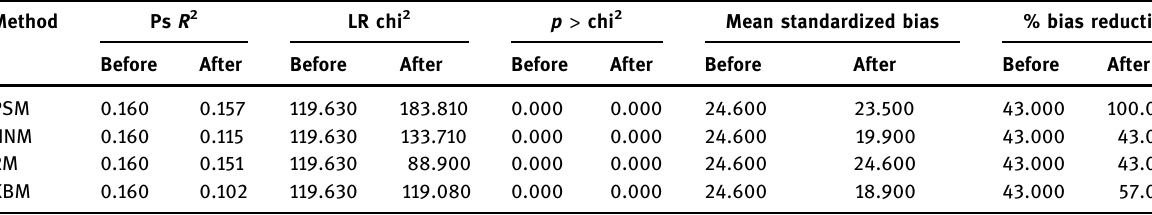
Table 7: Summary statistics of the matching quality indicators